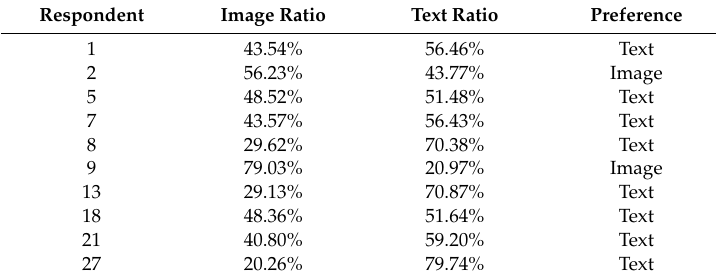
Table 12. Respondents with high anxiety.